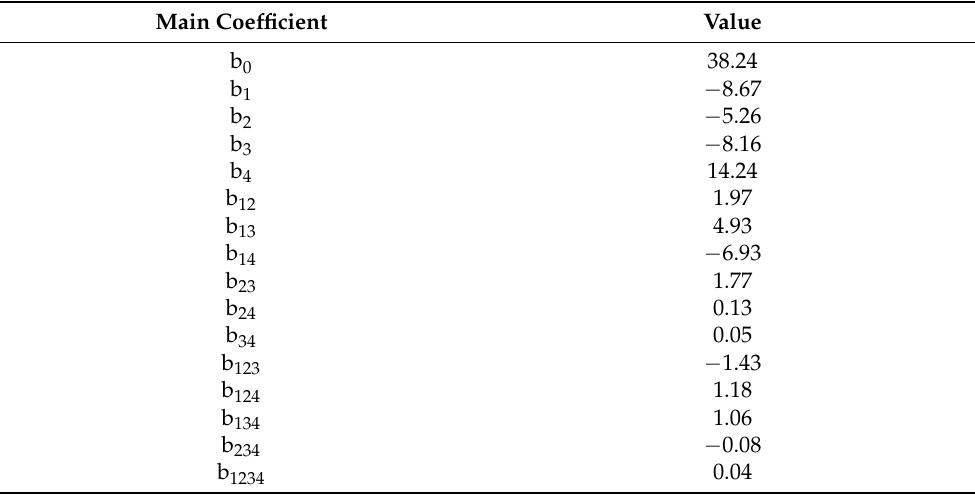
Table 7. Values of model coefficients for adsorptive removal of